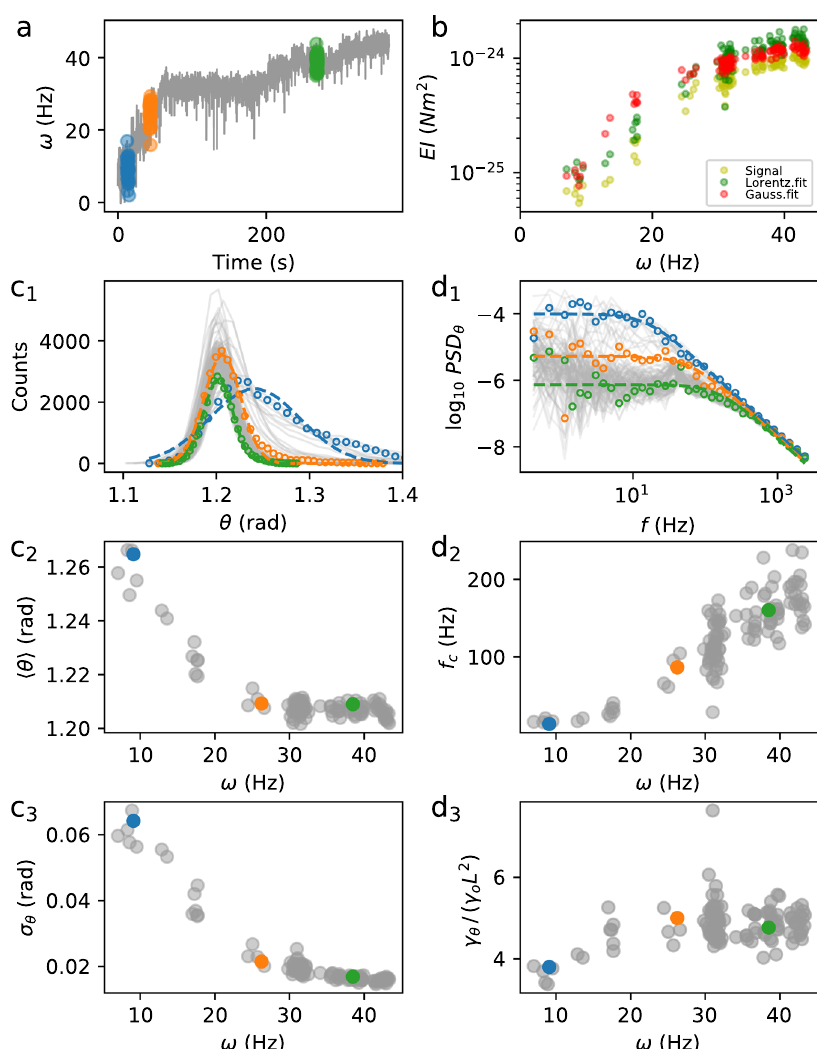
Fig. 3 Single motor fl uctuation analysis. a One resurrection trace of the speed ω ( R b = 500 nm, to increase readability the trace is here fi ltered with a 8 ms running window median fi lter) is divided in time-windows of 3 s to allow local fl uctuation analysis of the signal θ ( t ). Three windows are highlighted, and their colors are used for the corresponding points in all the panels. b Bending stiffness EI as a function of speed ω , calculated in each time-window following the analysis described in the text, using the raw signal θ i ( t ), the Gaussian fi t to its probability distribution, and the Lorentzian fi t to its power spectral density. c1 Probability density of all the θ i along the trace (gray lines, while the points and their colors correspond to the windows shown in a ), fi t by a Gaussian function (dashed lines for the three windows highlighted). c2 Mean value 〈 θ i 〉 as a function of the mean speed ω in the time-window. c3 Standard ð f Þ (gray lines) of all the time-windows along the trace, and deviation of θ i as a function of the mean speed ω in the time-window. d1 Power spectra PSD θ i Lorentzian fi t (dashed lines) for the three windows highlighted in a ) (points). d2 Corner frequency f c of the Lorentzian fi t in d1 as a function of speed ω . d3 Drag coef fi cient γ θ from the Lorentzian fi t, normalized to the bulk value γ o L 2